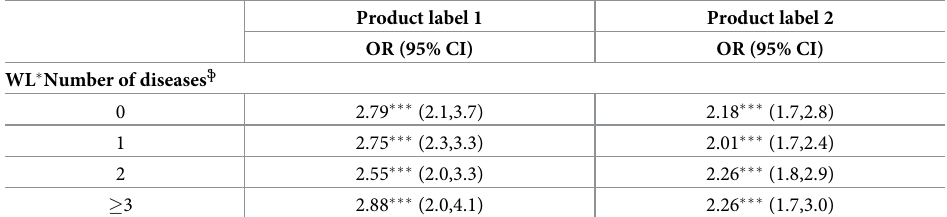
Table 4. Odds ratio of correct classification of two product labels using WL over GDA by number of